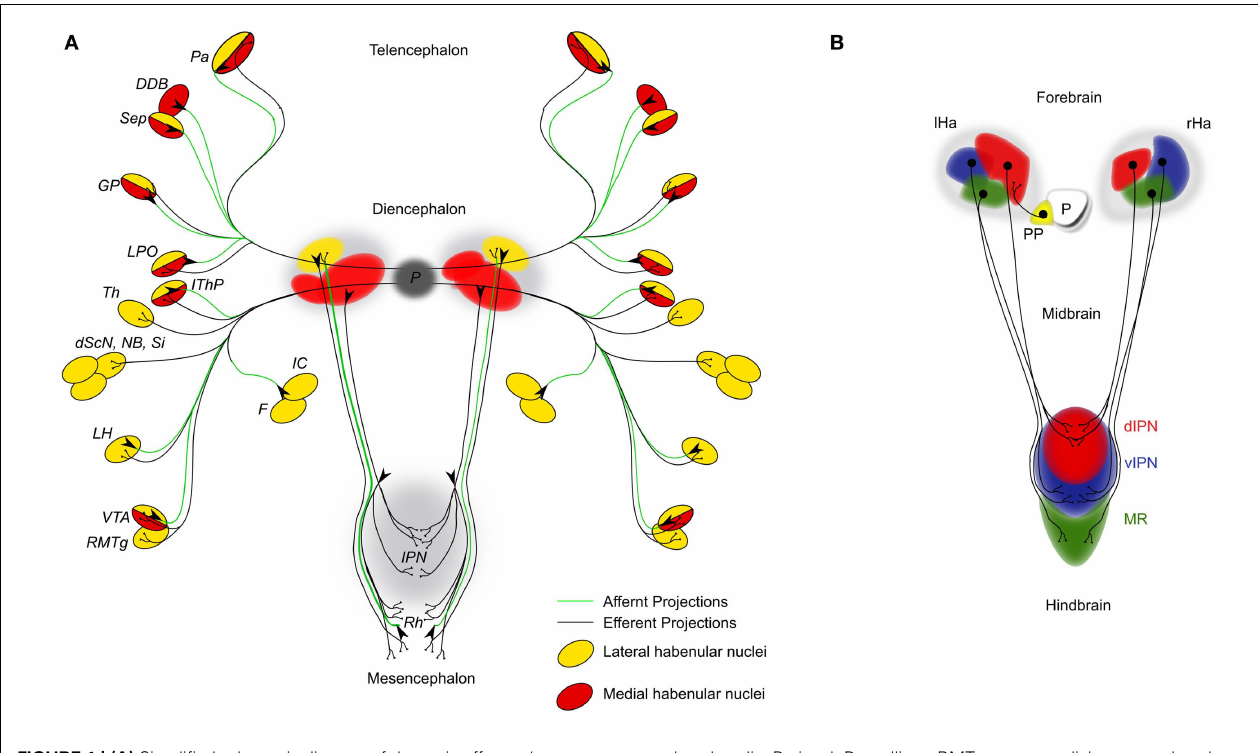
FIGURE 1 | (A) Simplified schematic diagram of the main afferent (green lines) and efferent connections (black lines) of the dorsal diencephalic conduction system in the mammalian brain.Targets and origins of axons related to the lateral habenulae are highlighted in yellow; those of the medial habenulae in red. DDB, nucleus of diagonal band; dScN, dorsal superchiasmatic nucleus; F, fornix; GP, globus pallidus (primate homolog of the teleost entopeduncular nucleus); IC, internal capsule; IThP, inferior thalamic peduncle; LH, lateral hypothalamic area; LPO, lateral preoptic area; NB,